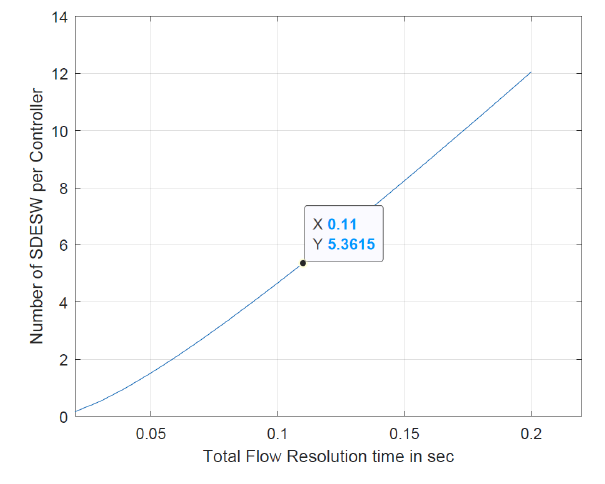
Figure 5. Number of SDESW per Controller. Table 4. Optimal Controllers.